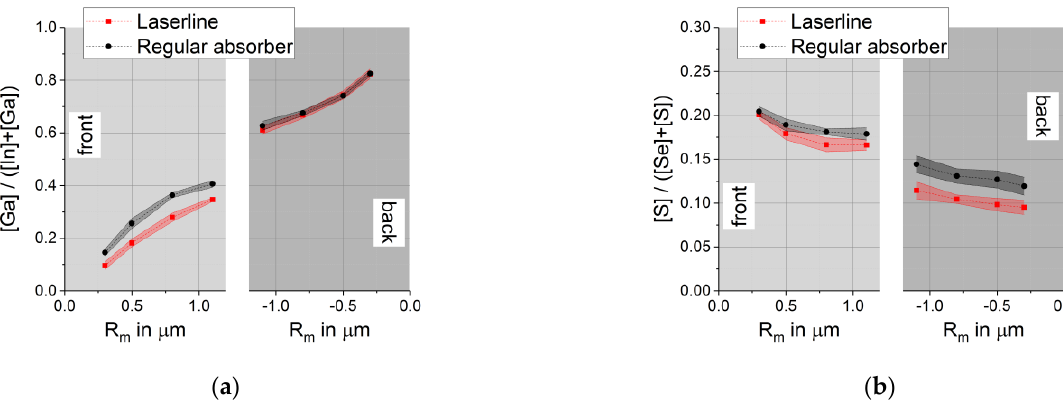
Figure 9. Comparison between the regular absorber and the absorber above the laser cut for sample D: ( a ) [Ga]/([In] + [Ga]) ratio calculated from EDX with different acceleration energies; ( b ) [S]/([Se] + [S]) ratio calculated from EDX with different acceleration energies.